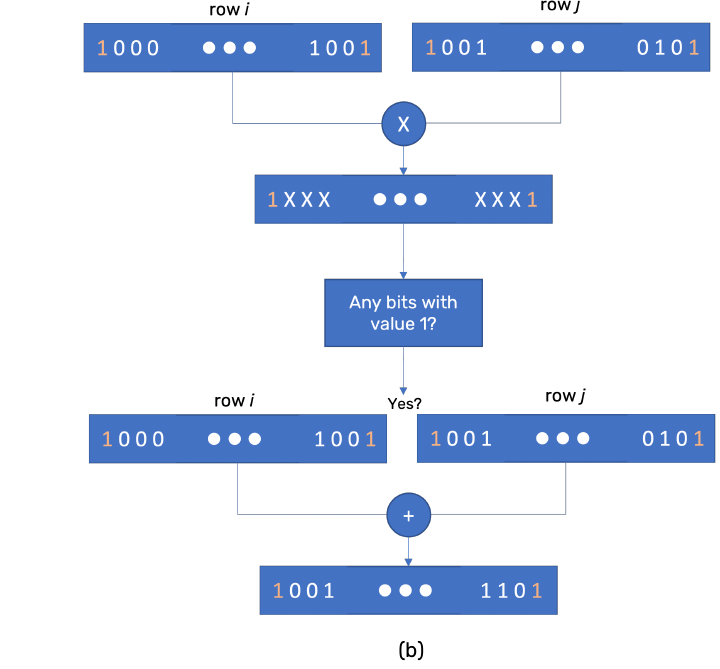
Figure 2. ( a ) The connection matrix has a row size equal to the number of samples. Each row has a bit size equal to the number of samples, implemented using 32-bit unsigned integers. If sample i and j are connected, then bit j in row i has value 1 and bit i in row j has value 1. ( b ) If the bitwise AND result between row i and j have any bit with value 1, the two points have a connection path. If they have a connection path, then the bitwise OR gives us the entire connected points set.